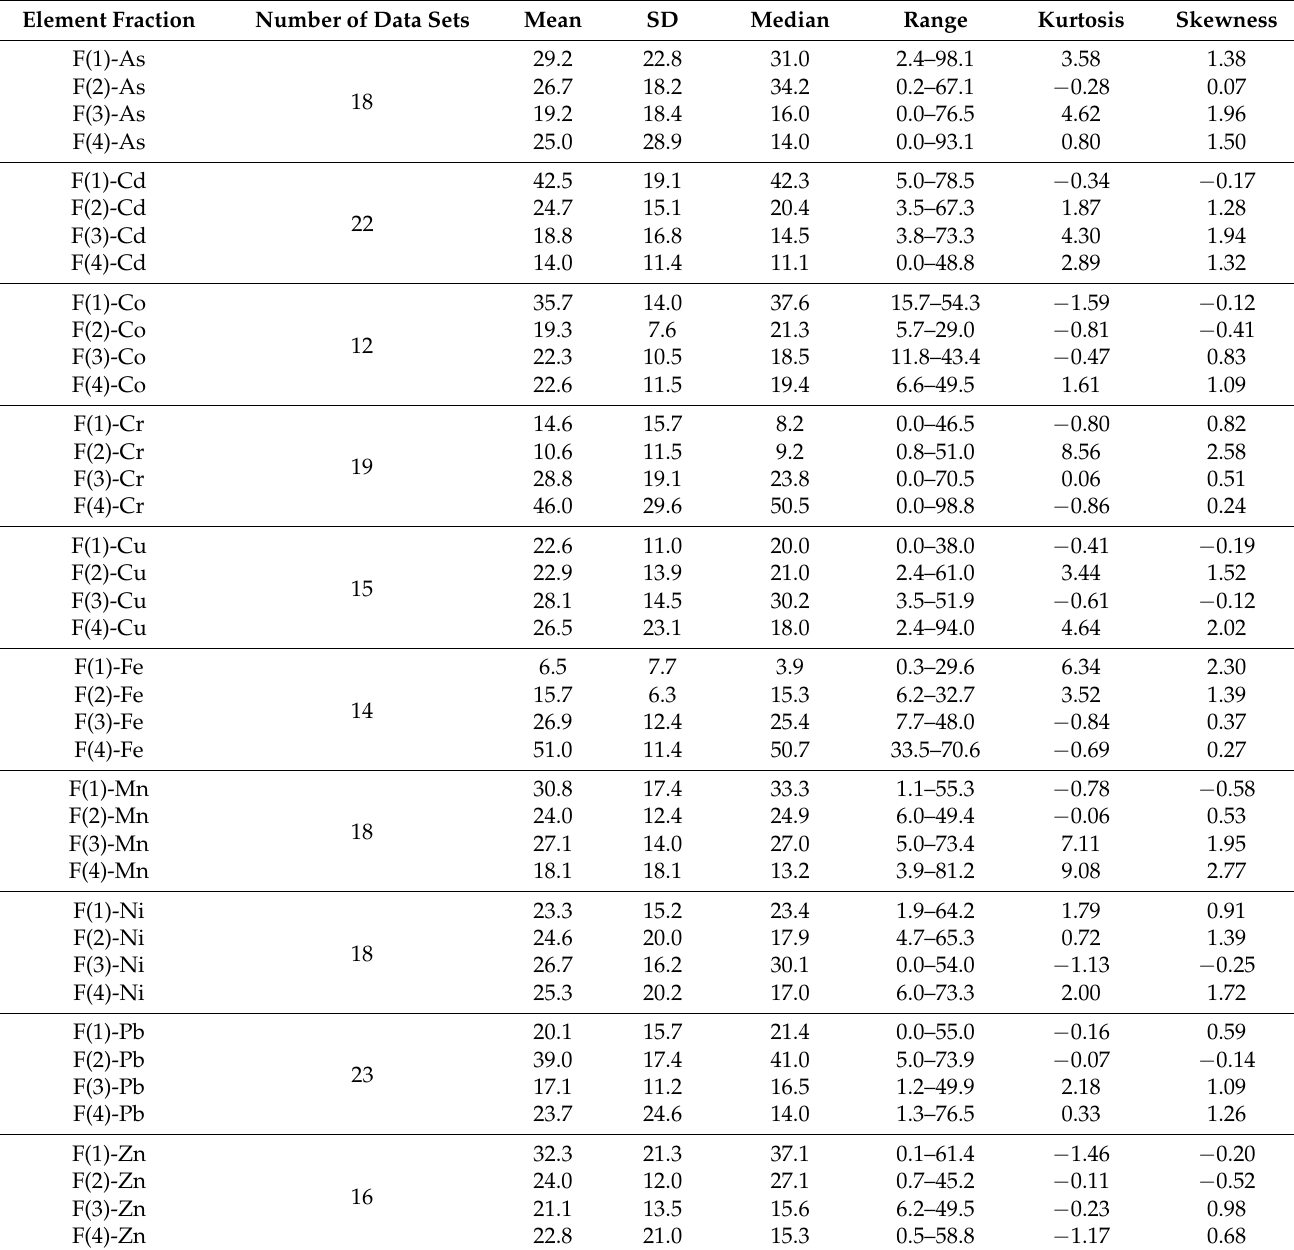
Table 2. Descriptive statistics of literature data of operational speciation of As, Cd, Co, Cr, Cu, Fe, Mn, Ni, Pb and Zn occurring in urban air particulate matter by Fern á ndez Espinosa procedure. The element fraction content is given as a percentage of its total content